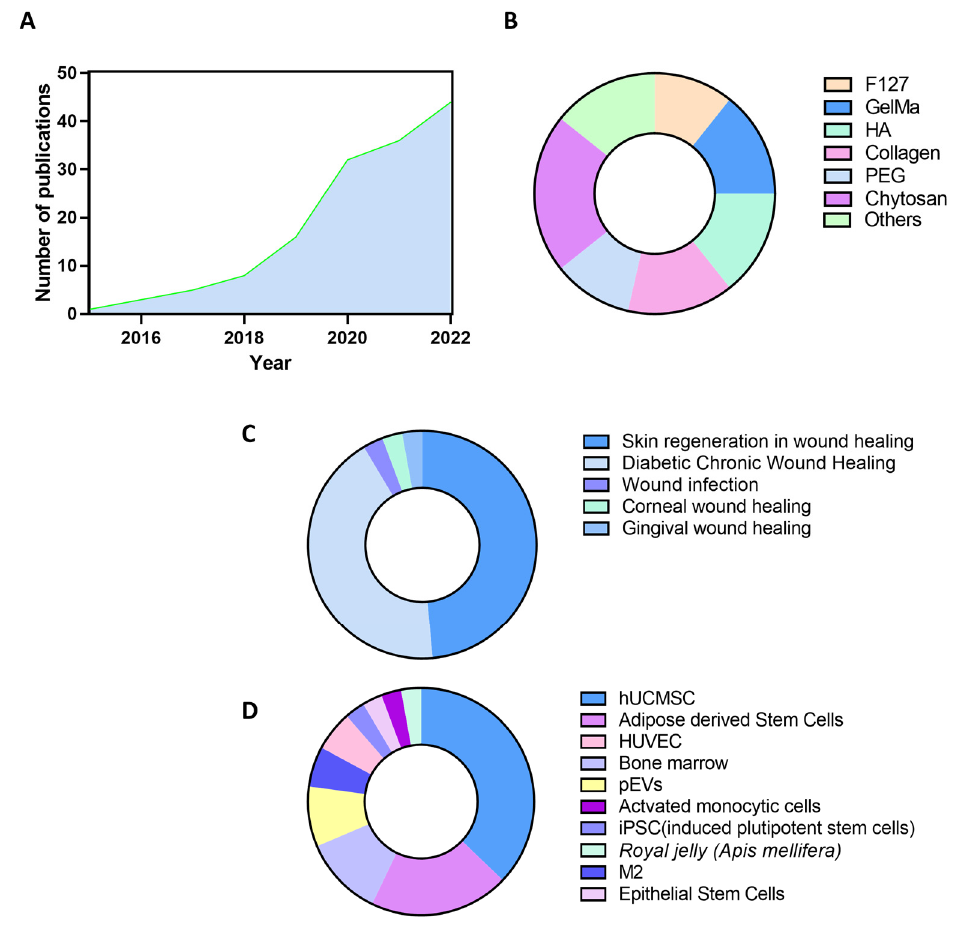
Figure 2. Data analysis of EV-based biomaterials research literature. ( A ) Number of publications in Pub Med with “EVs AND (biomaterials or materials) AND wound healing” per year. ( B ) Absolute frequency diagram of biomaterials and hydrogels used in EV-based biomaterials research. ( C ) Ab- solute frequency diagram of therapeutic use of EV-based biomaterials in acute and chronic wound healing. ( D ) Absolute frequency diagram of EV sources.